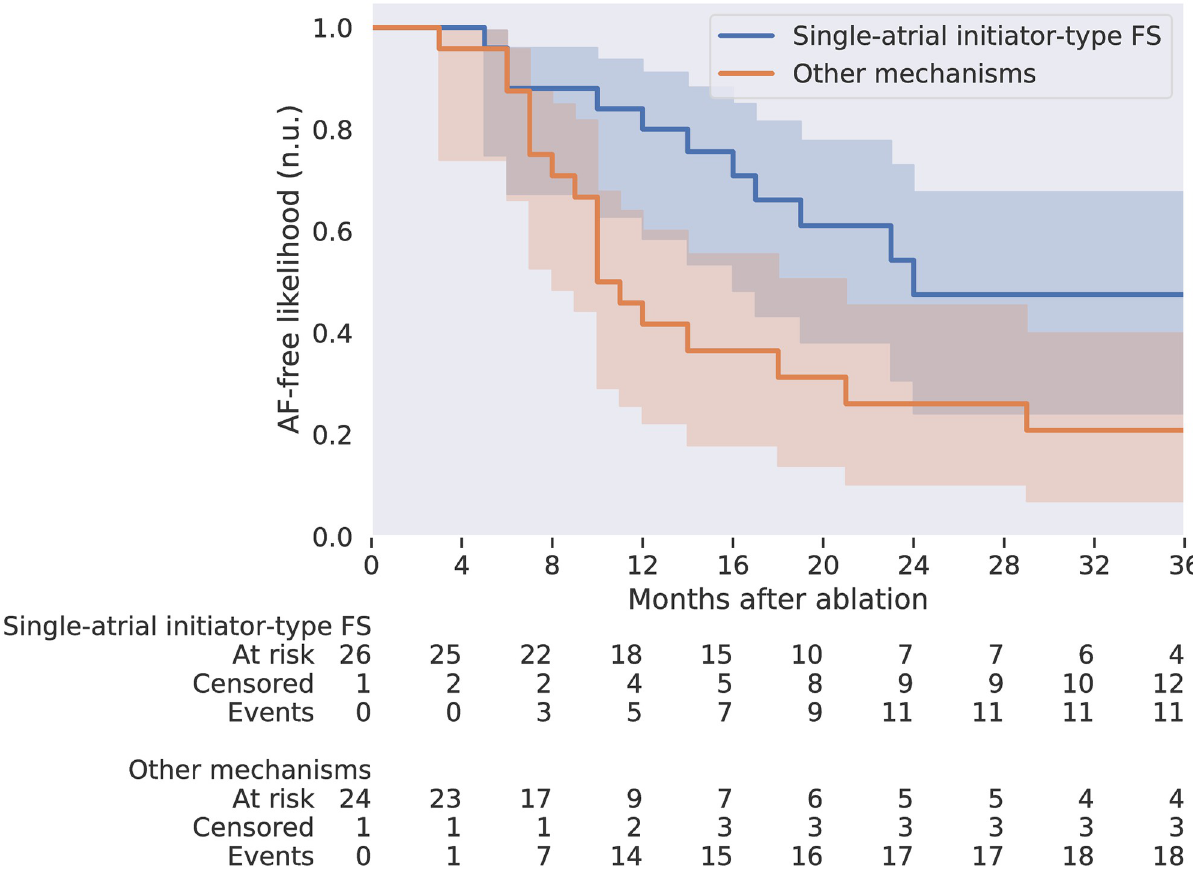
Fig 8. Kaplan–Meier curves of two paroxysmal AF patient groups, showing the post-ablation AF-free likelihoods up to three years. The grouping was according to whether the AF episodes in the patient were predicted as driven by initiator-type FS originating from a single atrium. The shading shows the 95% confidence interval of the Kaplan–Meier curves. The first group had better two-year and three-year AF-free outcomes than the other group, with p-values of logrank tests both < 0.01. n.u.: normalized unit.